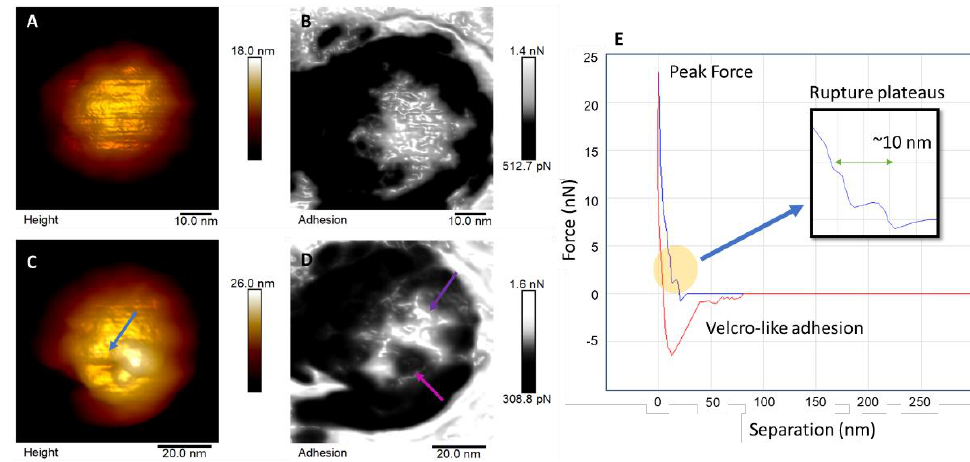
Figure 3. Indentation experiments. ( A ) Height image of a viral particle (VP) and ( B ) its respective adhesion map. At the top of the particle, it is possible to observe differences in charge due to different protein domains. After 30 cycles of indentation, the viral particle shown in image ( C ) reveals the damage caused to the surface of the VP, as evidenced by the blue arrow. It is even possible to observe the pyramidal pattern of the AFM probe geometry. This is associated with the nature of the protein coat of CHIKV, which confers greater rigidity and plasticity. In ( D ), it is possible to observe changes in the distribution of adhesion forces on the VP after indentation, with the purple arrow indicating the site of more positive charge and the pink arrow indicating the site where the indentation occurred, leaving a more negative surface charged location. ( E ) Representative AFM force curve. Force curve showing viral shell rupture (yellow circle). The first event occurs at ~1.4 nN and the second at ~4.1 nN. The insert shows rupture ramps that reveal two layers approximately 10 nm thick (green arrow). The retraction curve (red curve) shows the adhesion force with a Velcro-like pattern, characteristic of protein bond